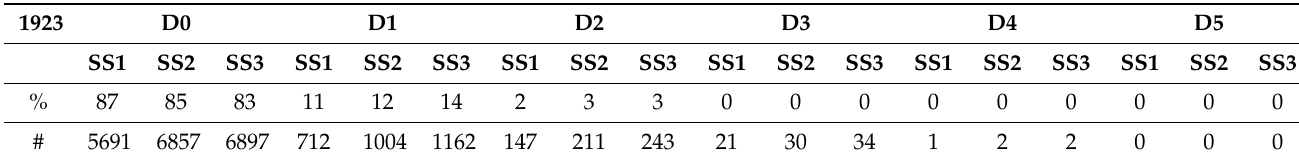
Table 8. Percentage and number of residential buildings per damage level per scale scenario and the corresponding ground motion shown in Figure 8, for the earthquake event of